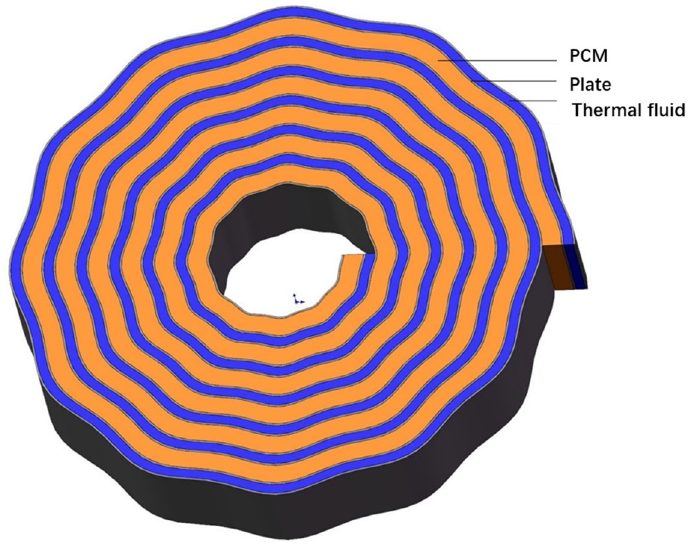
Figure 1. Structure of the wave-like spiral plate cold storage tank.